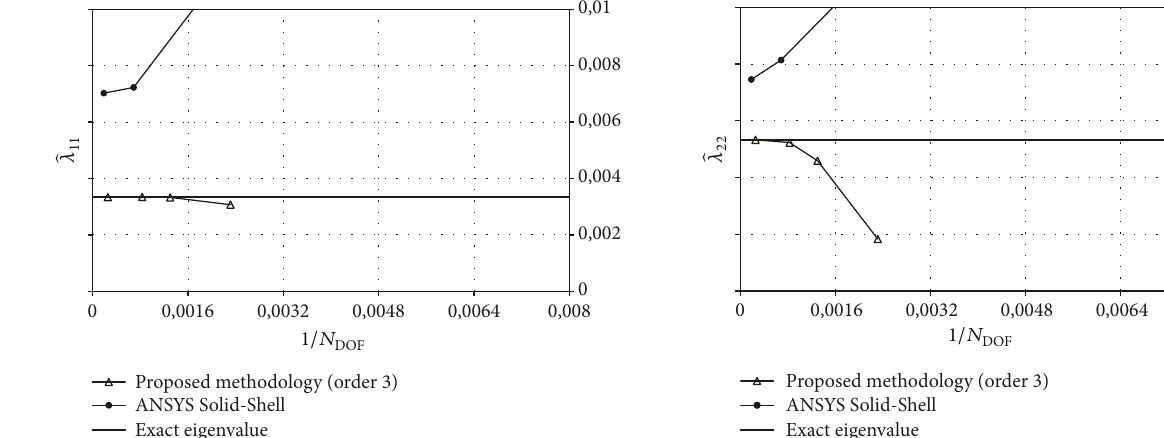
Figure 24: Hinged rectangular plate: vergence).